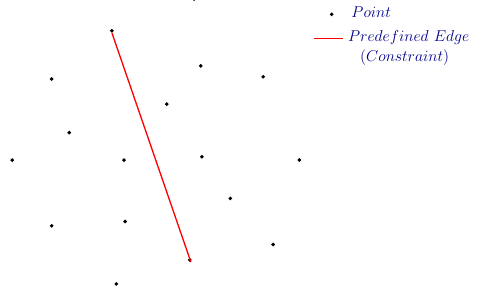
Figure 4: Point set and constrained edge for